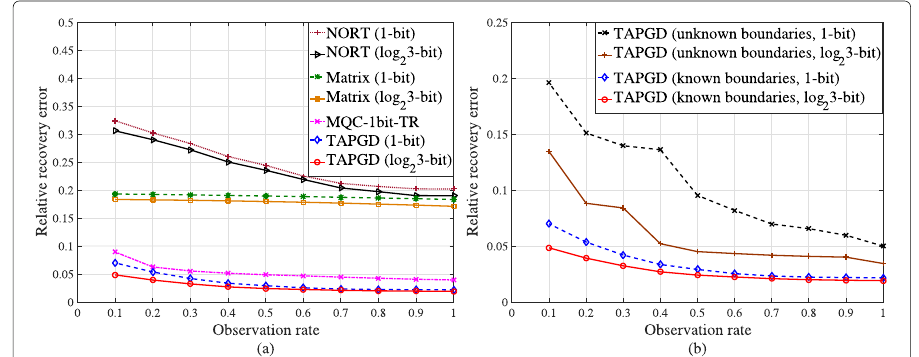
Fig. 5 a Relative recovery error when the observation rate changes. b Relative recovery error of unknown boundaries